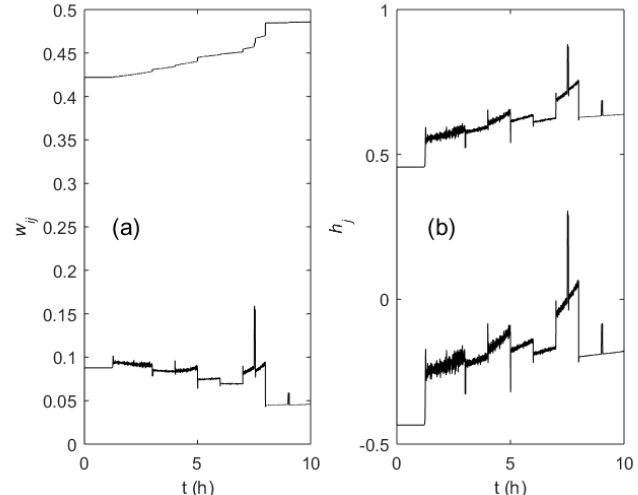
Figure 11. Evolution of the ANN weights w ij ( a ) and h j ( b ) during the fed-batch process (one node in the hidden layer and one node in the output layer used).